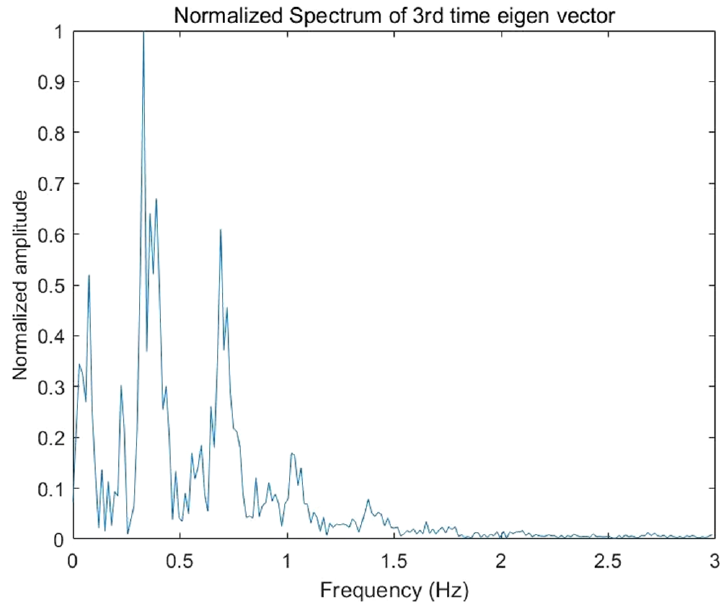
Figure 20. Normalized spectrum of the third temporal eigenvector. The Moving Target Indicator (MTI) method is adopted to attenuate the breathing harmonics. Figure 21 shows the principle of a double-delay MTI harmonic canceller. Set the system delay T r to the inverse of the respiratory frequency RF . The response of the double-delay MTI harmonic canceller system is demonstrated in Equation (45):